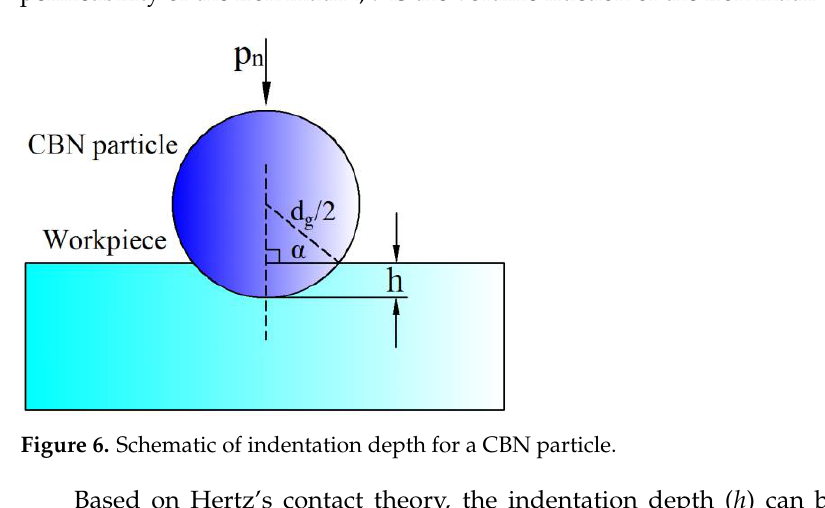
Table 2. The details of test workpiece. Hardness